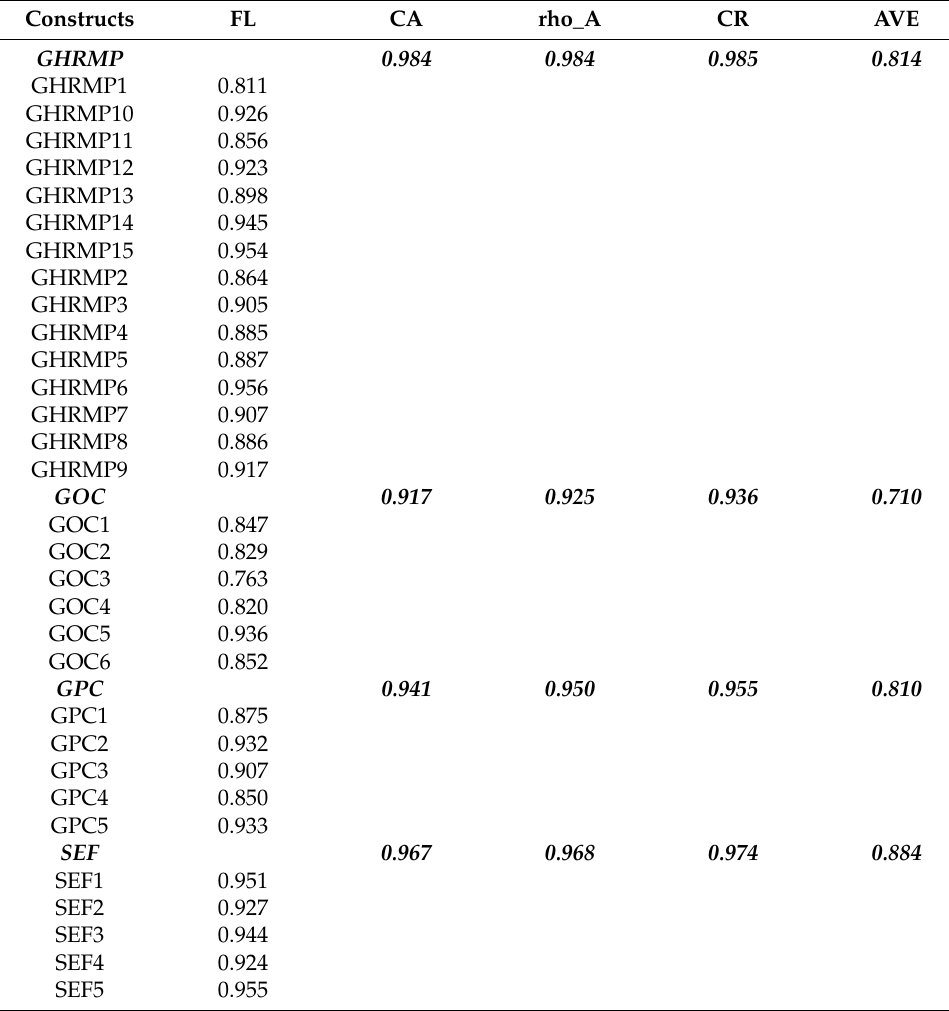
Table 3. Factor analysis, data validity, and reliability.